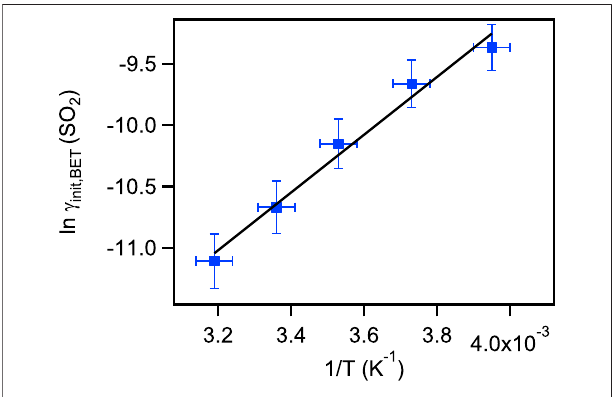
FIGURE 7 | Relationship between the initial uptake coef fi cients of sulfur dioxide on two coal fl y and temperature.